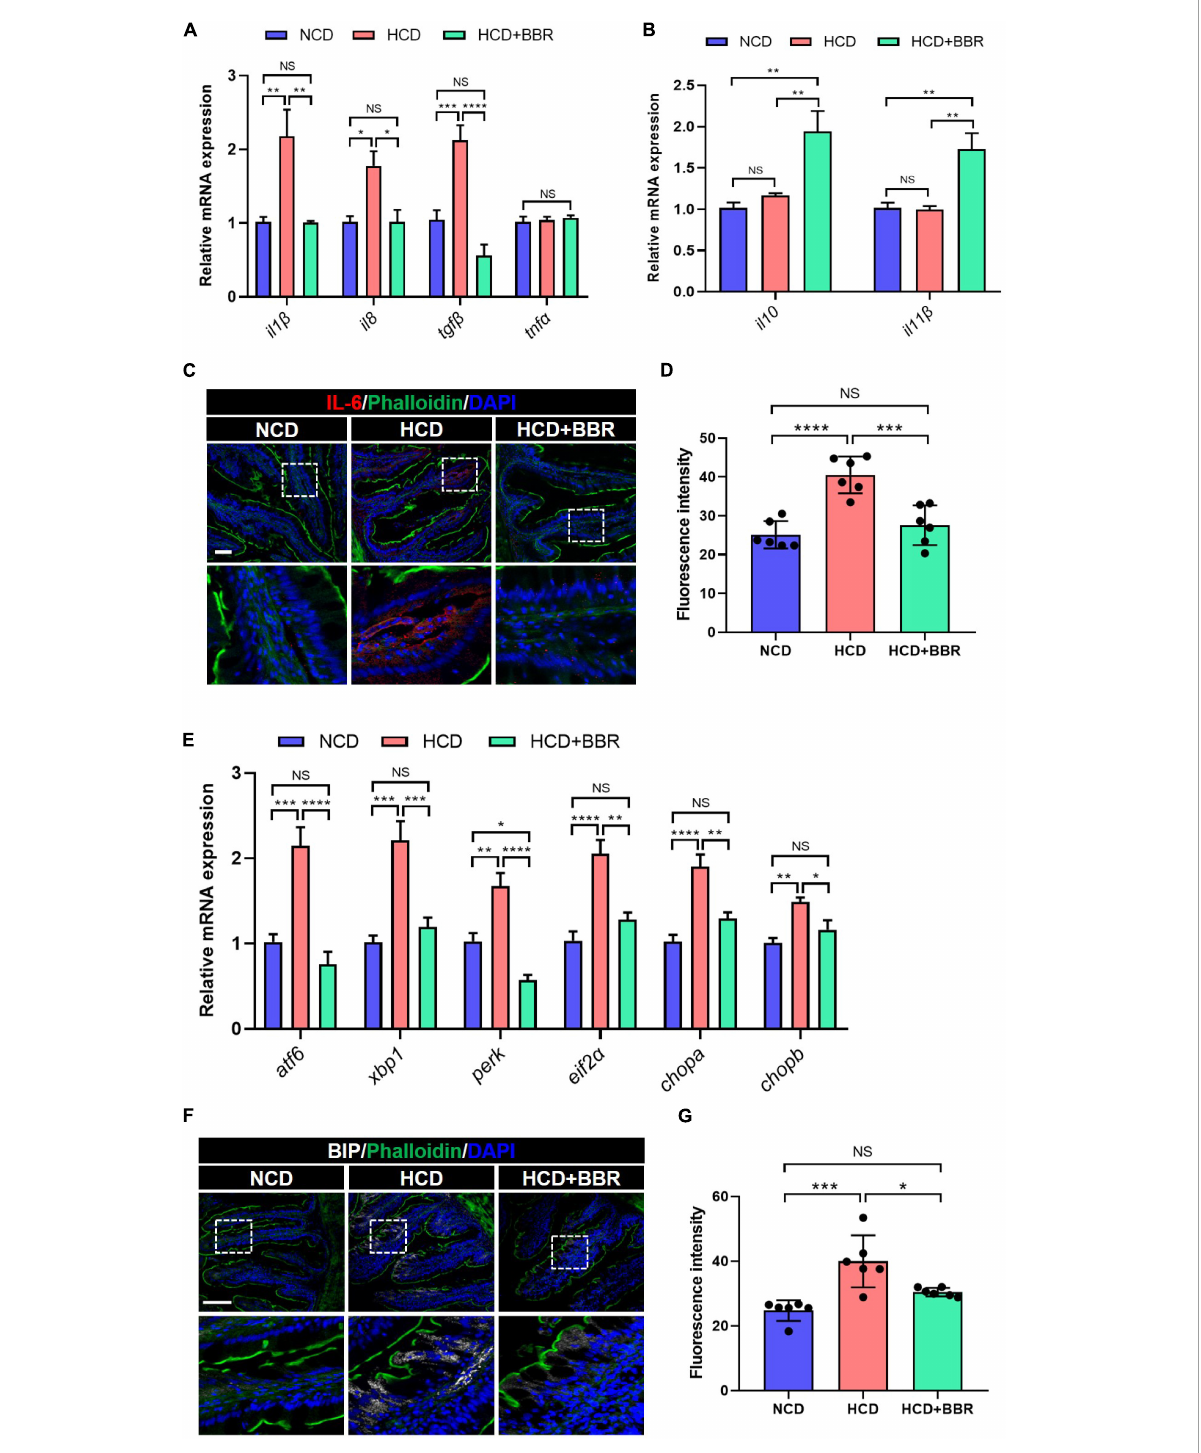
FIGURE4 Dietary BBR alleviated the HCD-induced inflammation and ER stress in the intestine of largemouth bass. (A) Expression level of proinflammatory genes. (B) Expression level of anti-inflammatory genes. (C) IL-6 (red) staining images of intestinal sections (bar = 50 µ m). (D) Quantification of the IL-6 fluorescence intensity. (E) Expression level of ER stress-related genes. (F) BIP (white) staining images of intestinal sections (bar = 100 µ m). (G) Quantification of the BIP fluorescence intensity. Data are represented as means ± SEM ( n = 6). *, **, ***, ****Different from each other: * P < 0.05, ** P < 0.01, *** P < 0.001, **** P < 0.0001, NS means no significant difference (One-way ANOVA, Duncan’s post hoc